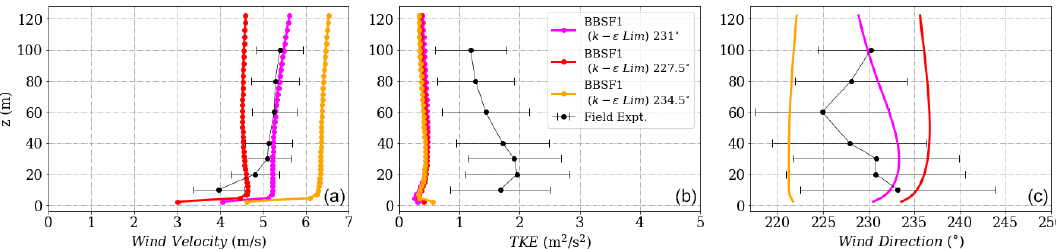
Figure D12. (a) Wind velocity magnitude, (b) wind direction and (c) turbulent kinetic energy at Tower 29 (tse13) for the BBSF